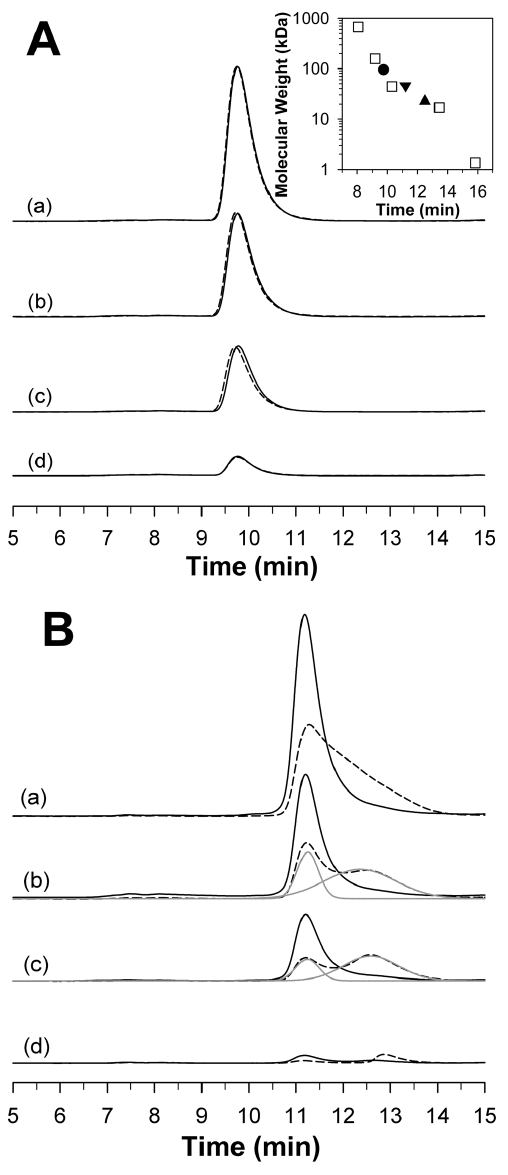
Figure 6. RP-mutant Ca MnSODc is susceptible to dimer dissociation. HPLC-SEC profiles of WT (solid line) and K182R, A183P (dashed line) Sc MnSOD are shown in Panel A. Inset: The plot of the molecular weight of the five standards (square), Sc MnSOD tetramer (circle) and Ca MnSODc dimer (triangle down) and monomer (triangle up) versus their retention time. The column was calibrated using five standards: 1) bovine thyroglobulin (670 kDa), 2) bovine c -globulin (158 kDa), 3) ovalbumin (44 kDa), 4) horse myoglobin (17 kDa), and 5) Vitamin B12 (1.35 kDa). HPLC-SEC profiles of WT (solid line) and K184R, L185P (dashed line) Ca MnSODc are shown in Panel B. Deconvoluted peaks are shown in grey lines. The protein concentration relative to monomer was 1 m M (a), 750 nM (b), 500 nM (c) and 200 nM (d). The elution buffer contained 10 mM potassium phosphate (pH 6.7). doi:10.1371/journal.pone.0062446.g006 single transition at 91 u C, corresponding to one irreversible process (Figure 8A–a). This suggests cooperativity in the aggregation of apo and metallated subunits in Sc MnSOD.